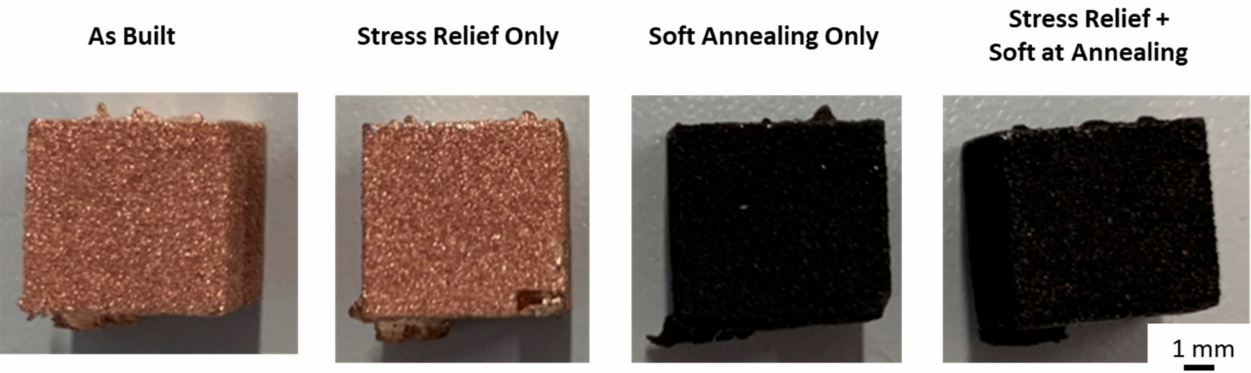
Figure 7. Heat treated Cu